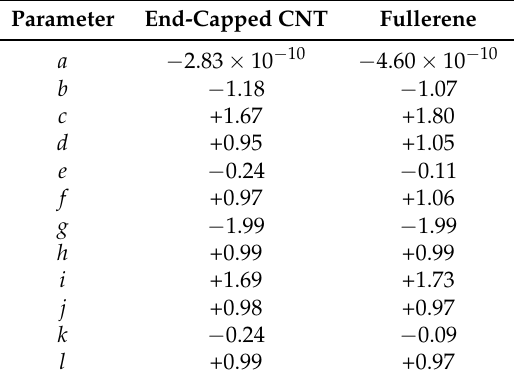
Table 2. Transfer function parameter values.